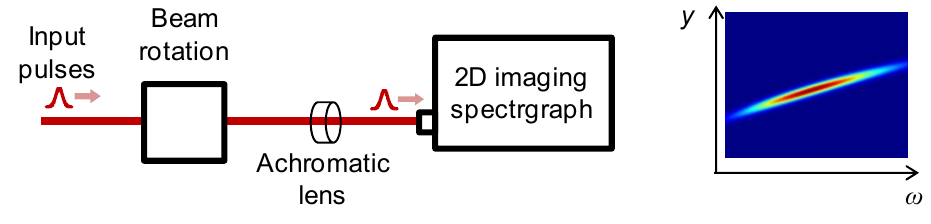
Figure 13. Schematic diagram for measuring the propagation direction angular dispersion. Beam Input rotation pulses 2D imaging spectrgraph Achromatic lens